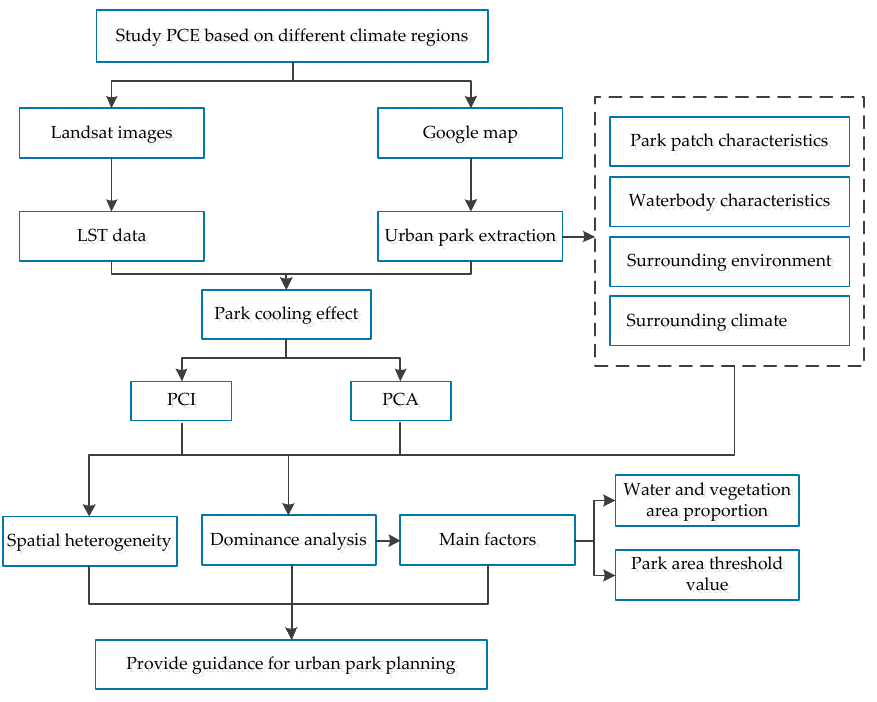
Figure 1. Technical flow